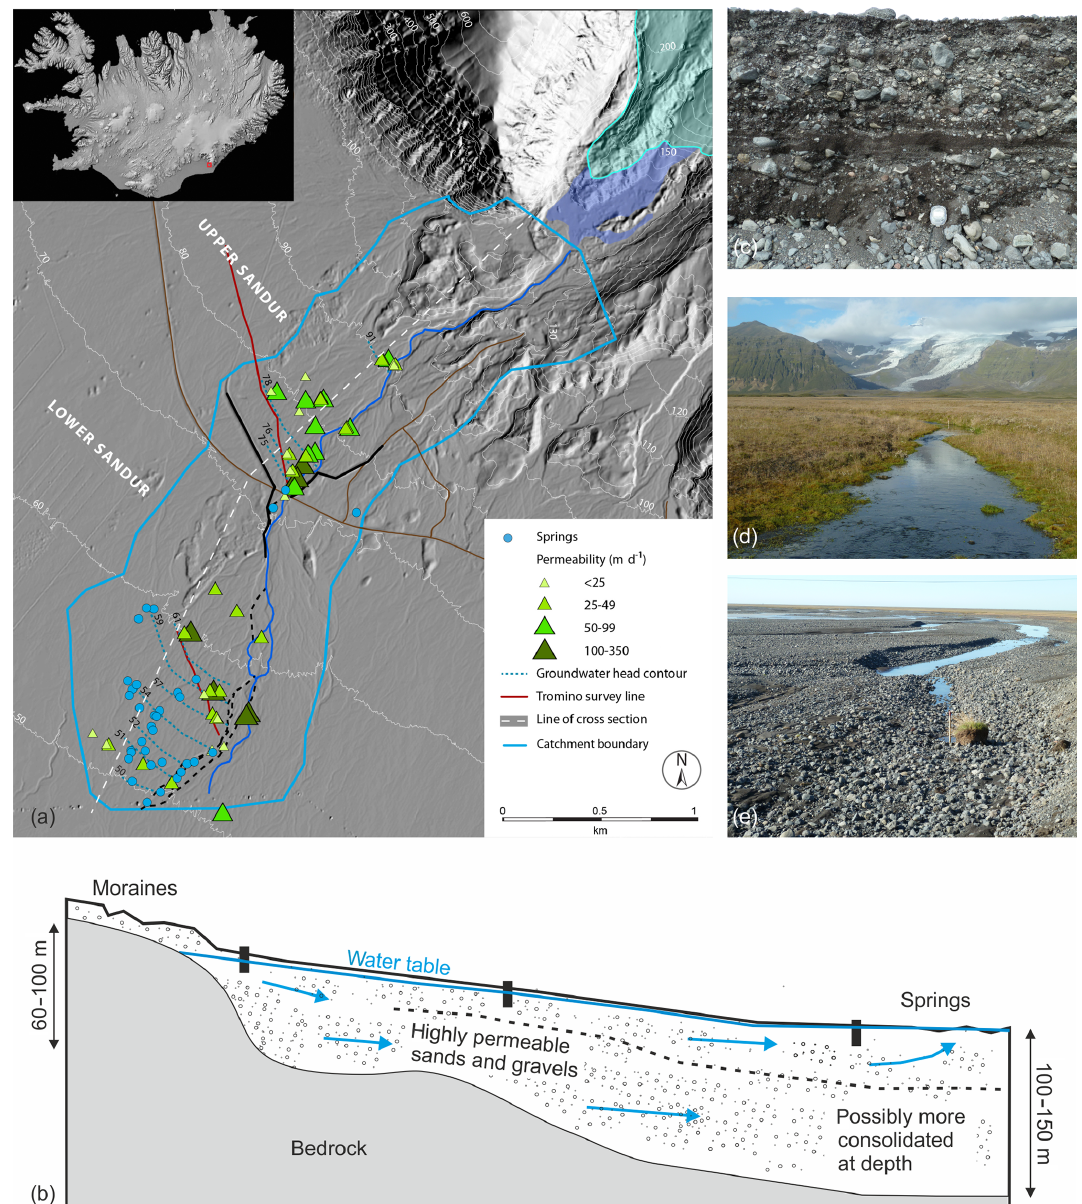
Figure 2. Geometry, geology, and hydrogeology of the sandur aquifer. (a) Hydraulic conductivity and summer groundwater-level contours. Other legend as Fig. 1. Hillshade model generated from LiDAR DEM © Veðurstofa Íslands, 2010; (b) schematic cross section of the hydrogeology, showing the locations of the piezometer transects, spring discharge area, and indicative groundwater flow lines; (c) geological section through the river bank showing heterogeneous glaciofluvial deposition; (d) perennial groundwater-fed stream on the lower sandur, associated with extensive growth of mosses and other aquatic vegetation; (e) groundwater discharge to the otherwise inactive river channel on the lower sandur, flowing to the active channel in the